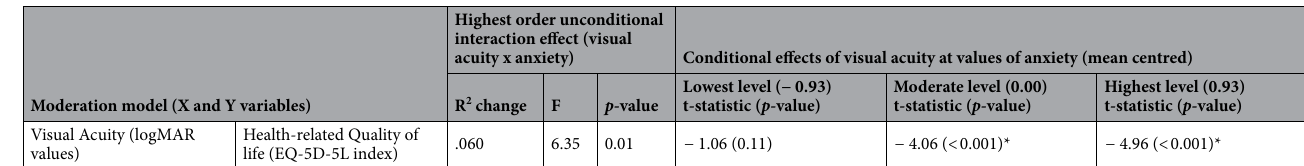
Table 5. Unconditional and conditional effects for the moderating effect of anxiety on the relationship between visual acuity and health-related quality of life. Moderation model examining levels of anxiety as a moderator of the relationship between visual acuity and quality of life (highest order unconditional interactions). The conditional effects of visual acuity were examined at different levels of anxiety to determine if the relationship between visual acuity and quality of life was different in patients presenting low, moderate, or high levels of anxiety. * p -value <